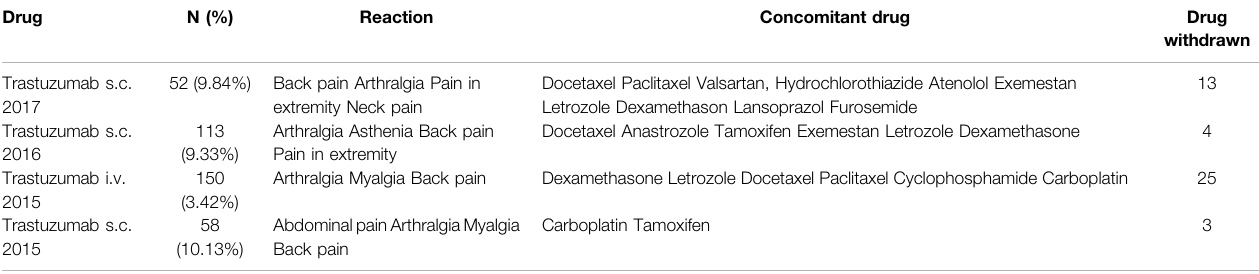
TABLE 4 | Cases of “ Musculoskeletal and connective tissue disorders ” of the intravenous and subcutaneous trastuzumab (2015 – 20). Drug N (%)